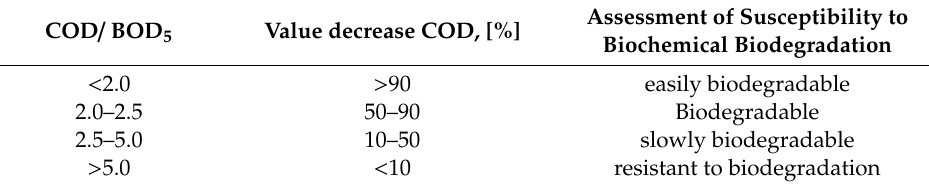
Table 1. Biodegradability of organic compounds [12,13].